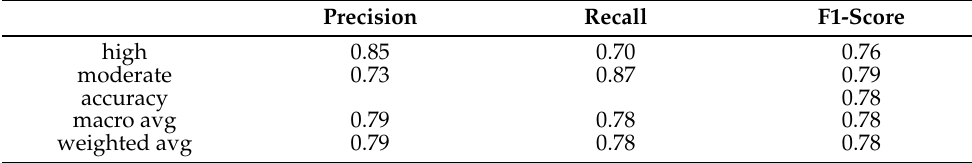
Figure 7. Confusion matrix, accuracy, and loss function for the total dataset for two levels of FOF (moderate vs. high). Table 9. Performance metrics for two classes of FOF (moderate vs. high) for the total